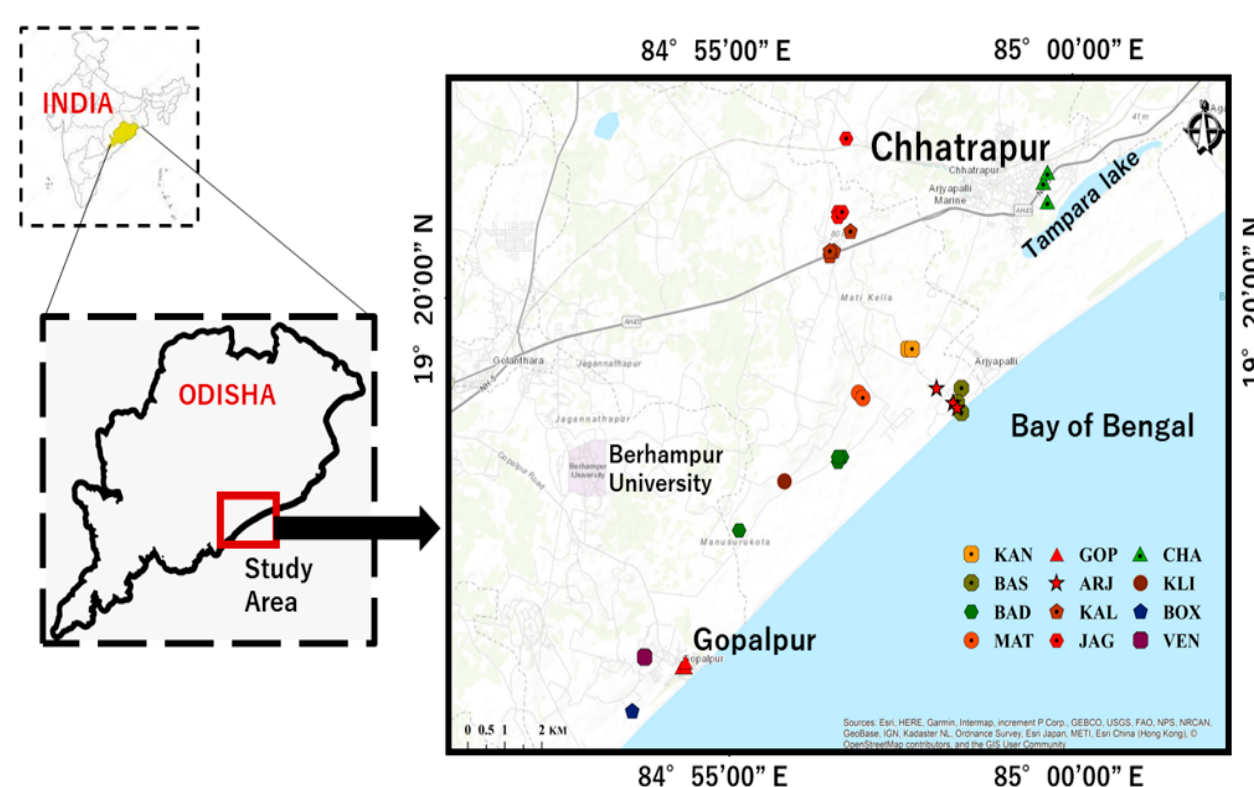
Figure 3. Map showing geographical locations of soils and ambient dose rates. (KAN—Kanamana; BAS—Basanaputti; BAD—Badaputti; MAT—Matikhalo; GOP—Gopalpur; ARJ—Aryapalli; KAL—Kalyaballi; JAG—Jagynasala; CHA— Chhatrapur; KLI—Kalipalli; BOX—Boxipalli; VEN—Venkatraipur). This map was prepared using Arc GIS 10.1. and enhanced using Coral draw software.